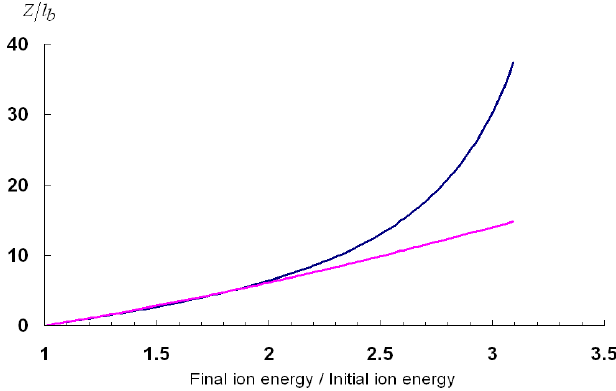
FIG. 14. (Color) Comparison of a tapered (red) and an untapered (blue) helix for W